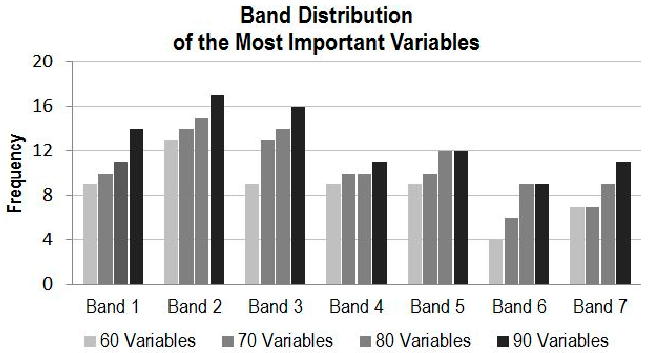
Figure 6. Band frequency with the number of the most important variables.